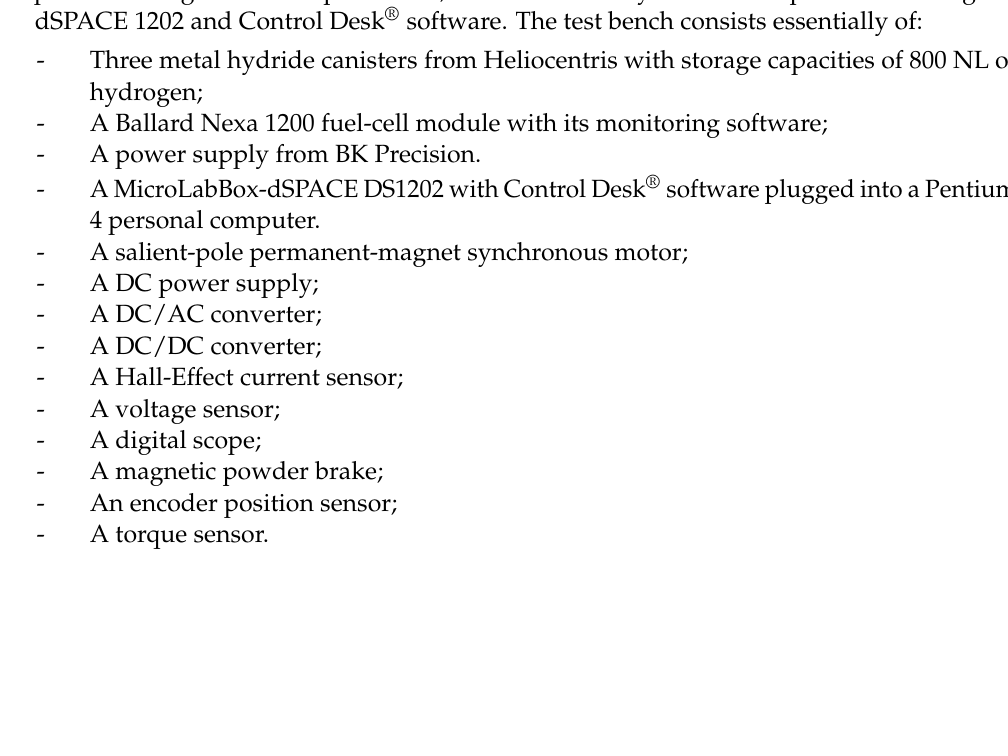
Figure 18. Current i d .